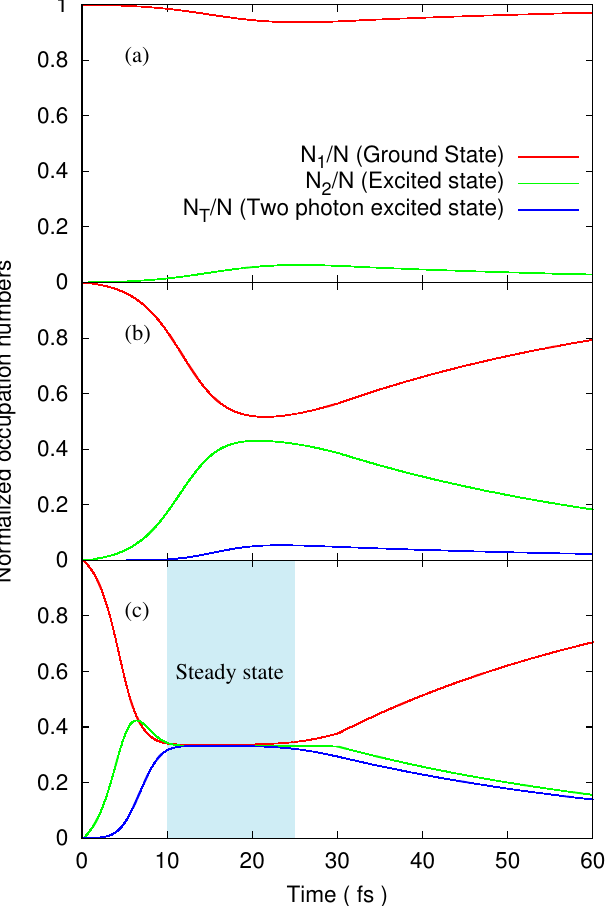
Figure 4. Time dependence of the density of occupation numbers (normalized by the total number N) at the end surface of the Al thin film (53 nm), using the two photon absorption (TPA) contribution at 92 eV photon energy (FEL pulse). The fluences of the incident pulse are 1.5, 15 and 150 J /cm 2 from the top to the bottom, respectively. The TPA cross-section σ 2 is set to 10 − 50 cm 4